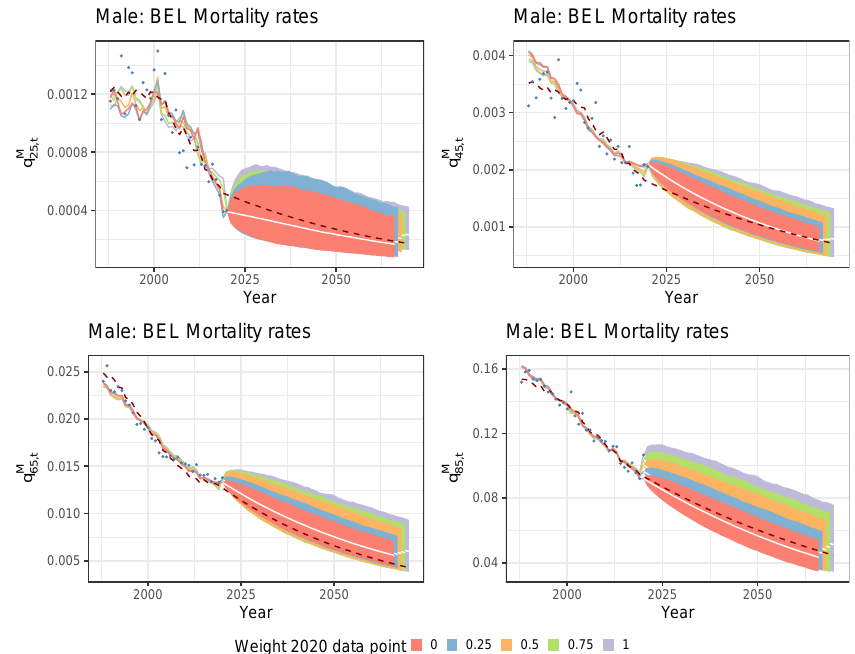
Figure 14. Estimated and projected Belgian mortality rates ˆ q x , t . Male data, ages 25, 45 ( top ) and 65, 85 ( bottom ), calibration period 1988–2020, projection period 2021–2070, method of Section 5.2. We show the 0.5%, median (white lines) and 99.5% quantile (fan charts), based on 10,000 simulations across each weighting scenario. The blue dots and the coloured, solid lines represent the observed and fitted mortality rates, respectively. The dark red, dashed line shows the calibrated mortality rates and the median quantile of simulations in the original IA | BE 2020 model. Figure 15 shows the estimated and projected period life expectancies for a 0 and 65 year old Belgian male (top) and female (bottom). Assigning the value zero to the weight λ 2020 leads to comparable results with the original IA | BE 2020 model (dark red, dashed line). This is in line with our expectations since we actually omit the pandemic data point in the calibration step when λ 2020 = 0. Table 4 depicts the cohort life expectancy in 2020 for a 0 and 65 year old male and female. Table 4. The cohort life expectancy for a 0 and 65 year old in 2020. The 0.5% quantile, median and 99.5% quantile obtained from 10,000 simulations are shown, for males and females. We obtain the best-estimate of the cohort life expectancy by taking the zero vector for the noise terms in Equation (4) to project the time dependent